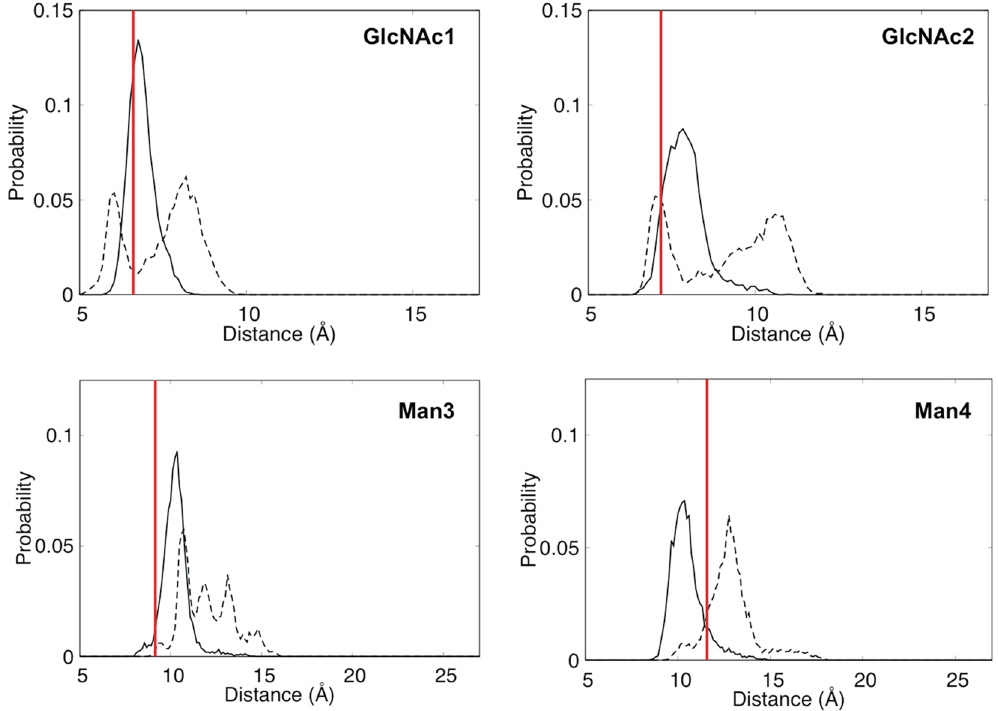
Figure 5. Distribution of distances between GlcNAc1 of IgG1-Fc and the inner residues (GlcNAc1, GlcNAc2, Man3, and Man4) of Asn162 glycan of sFc γ RIIIa in nonfucosylated (solid line) and fucosylated (dotted line) systems. Red bars represent distances obtained by crystallographic